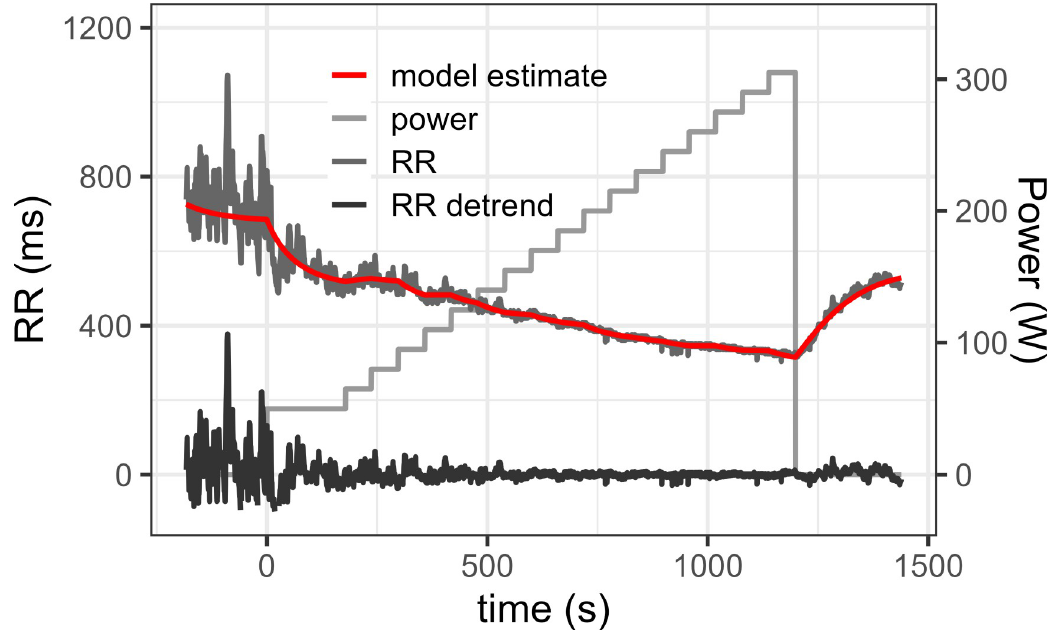
Fig 2. Example of RR series detrending. Measured RR interval during a maximal graded effort test, its estimation by a first order differential equation and the resulting detrended RR values obtained by subtracting the model estimate to the real data.